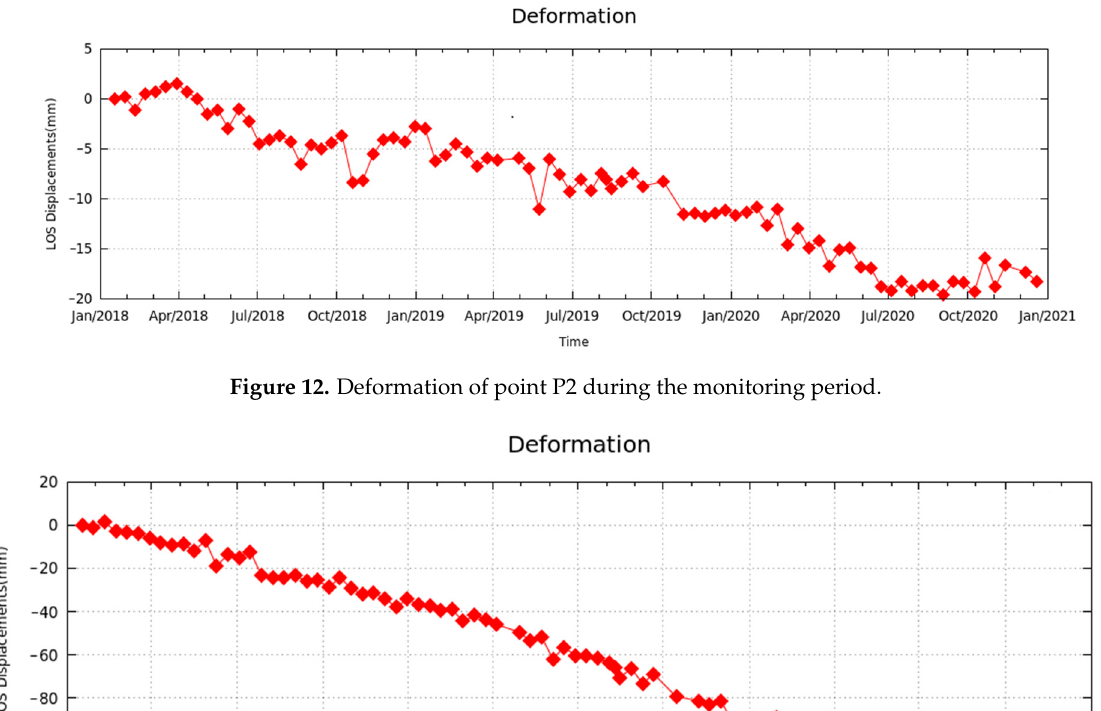
Figure 11. Deformation of point P1 during the monitoring period.